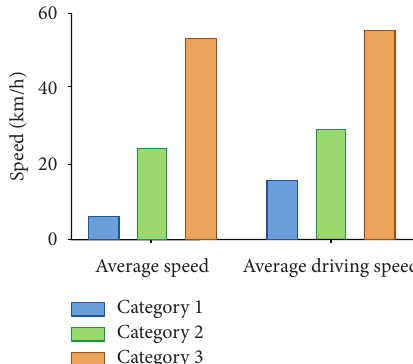
Figure 8: Average speed and average driving speed in each